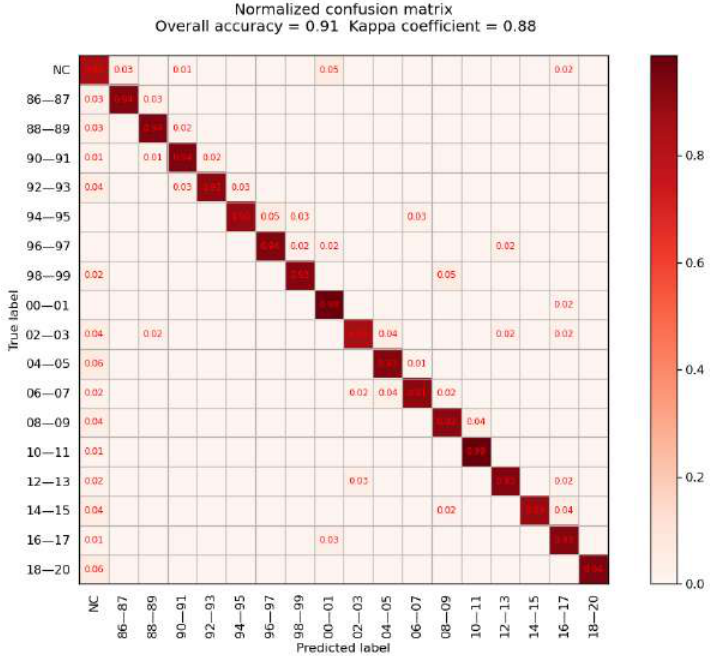
Figure 9. Confusion matrix of disturbance point detection from 1986 to